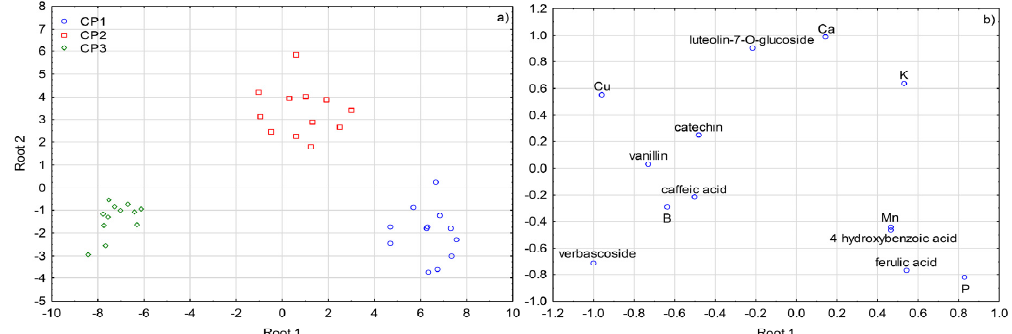
Figure 4. ( a ) Separation of olive leaves according to collecting period defined by the first two discriminant functions (roots) obtained by forward stepwise discriminant analysis (SLDA). ( b ) Standardized coefficients of biophenols and mineral nutrients selected by SLDA on the first two discriminant functions (roots). Collecting periods: CP1—October 2017, CP2—January 2018, and CP3—March 2018.